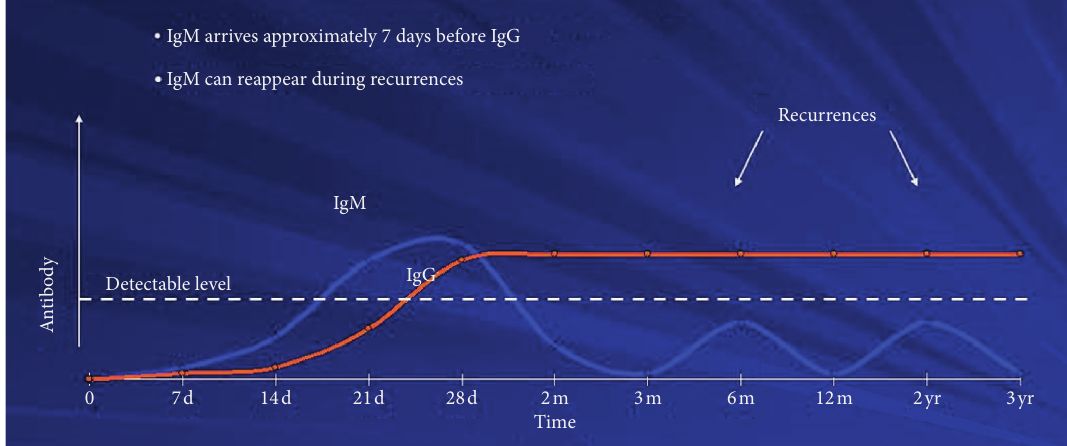
Figure 8: Graph of IgM and IgG response in HSV infection